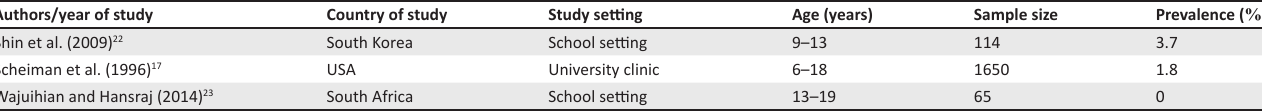
TABLE 3: Summary of studies on accommodative excess. Authors/year of study